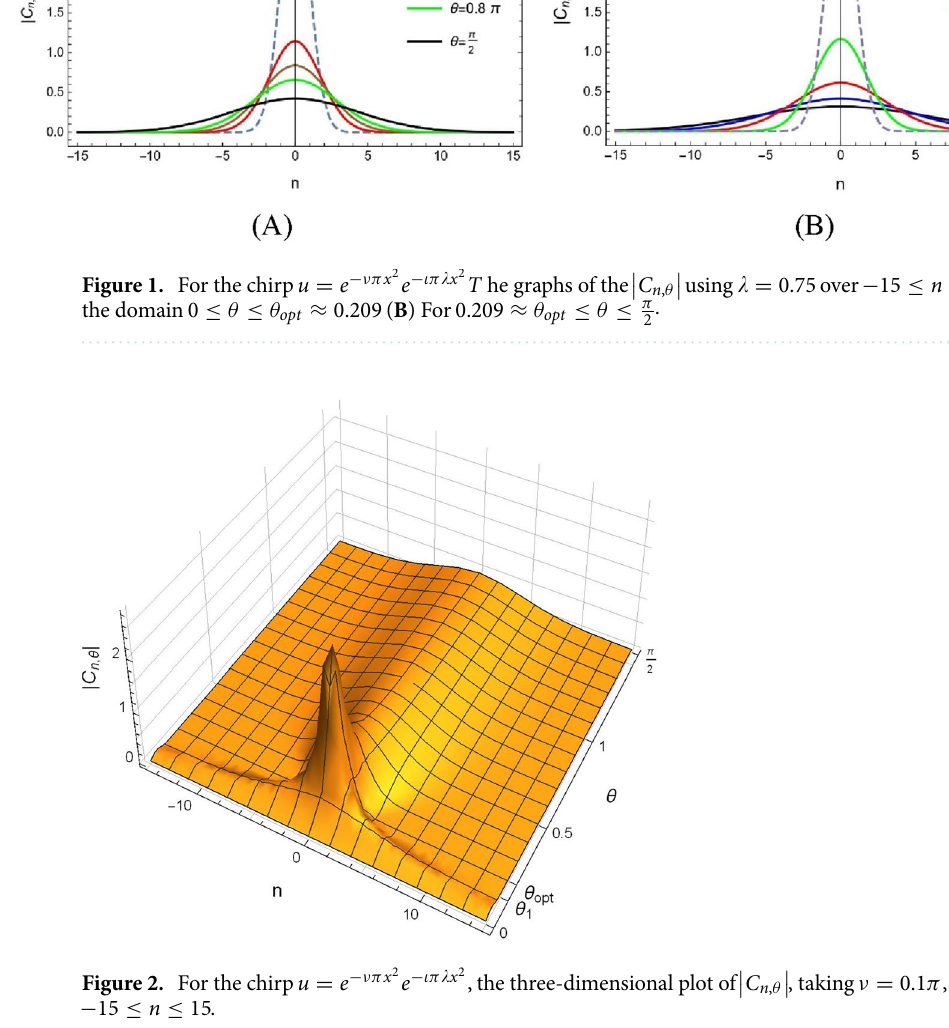
Figure 2. For the chirp u 15 15 n − ≤ ≤